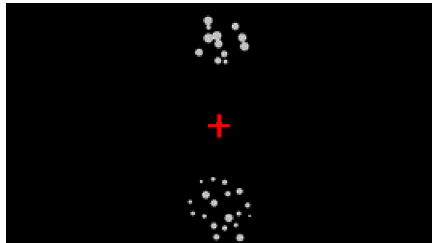
Figure 2. Stimulus example (stimuli are exaggerated for visibility). In each trial subjects had to decide whether the array presented on bottom (target) was smaller or bigger in numerosity than the array presented on top (standard). After their response, subjects were presented with a fixation cross that over the course of 600 ms was varying in size, as a warning signal to maintain fixation at the centre of the